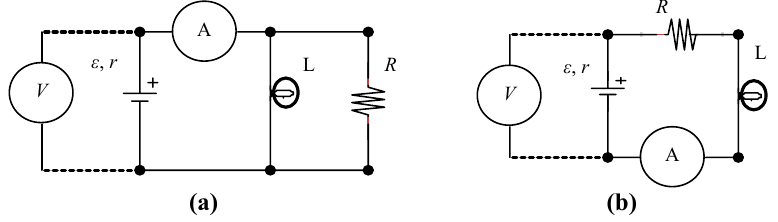
Fig. 9. Interactive simulations for the application of the Ohm’s and Kirchhoff’s